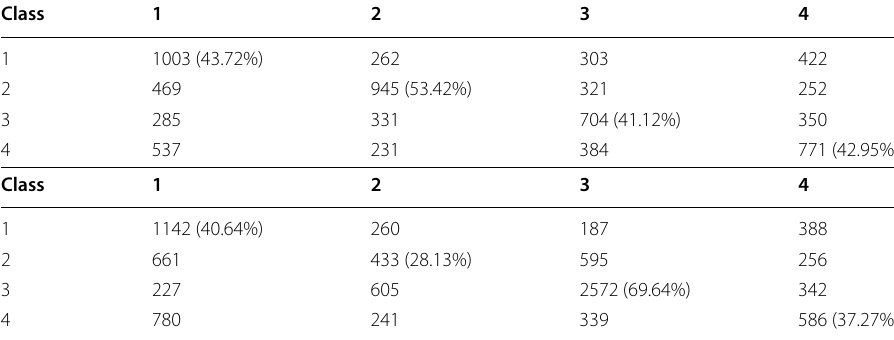
Table 3 Confusion matrices of participants 5 and 6 using